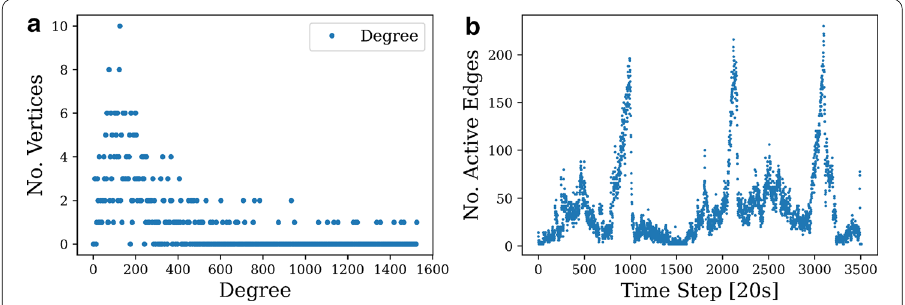
number of active edges per time step in the